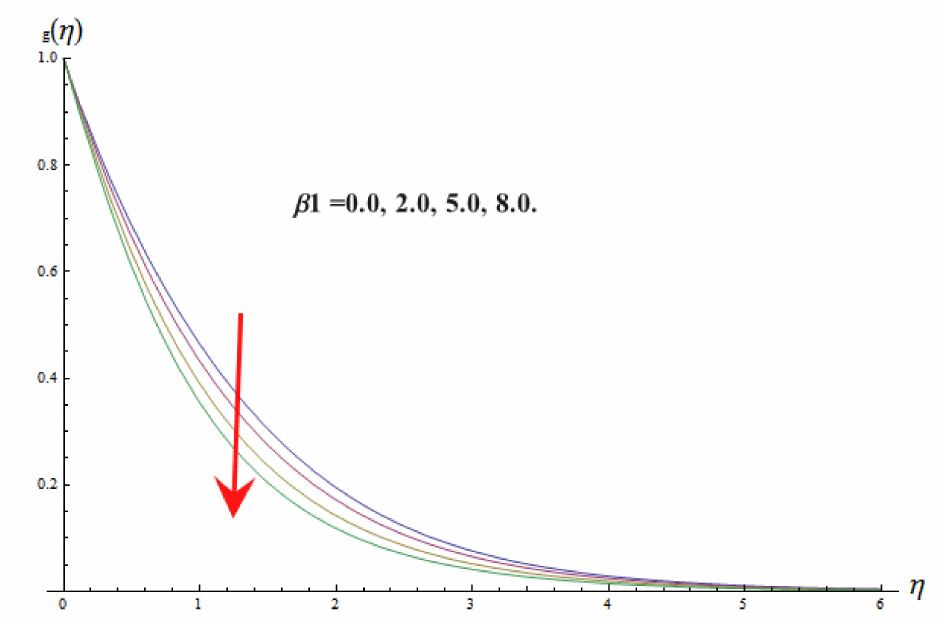
Figure 5. Impact of β 1 on g ( η ) keeping λ 1 = 2, Pr = 2, Br = 2, λ = 2, Ec = 0.2, Rd = 2, Γ = 0.5, β 1 = 0.2, Ha = 2, K ∗ = 2.